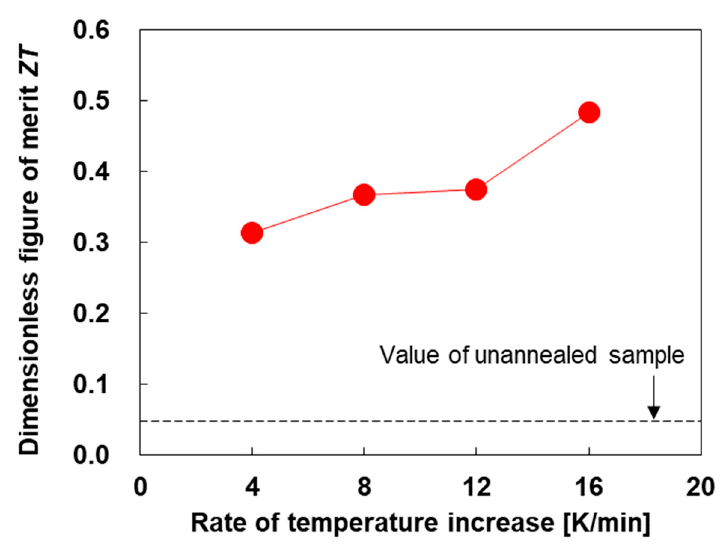
Figure 7. Dimensionless figure of merit ( ZT ) of the Bi 2 Te 3 thin films.